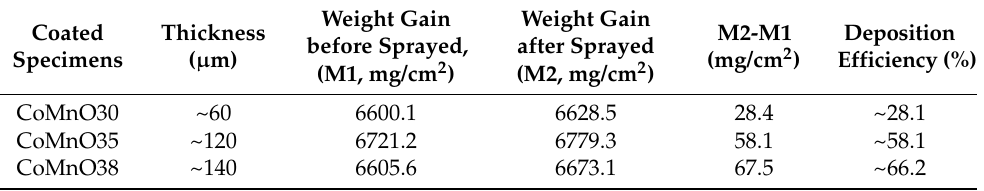
Figure 4. SEM images of the surface and cross-sectional morphology: ( a1 , a2 ) CoMnO30, ( b1 , b2 ) CoMnO35, ( c1 , c2 ) CoMnO38. Table 1. The influence of different atmospheric plasma factors on coated specimens.